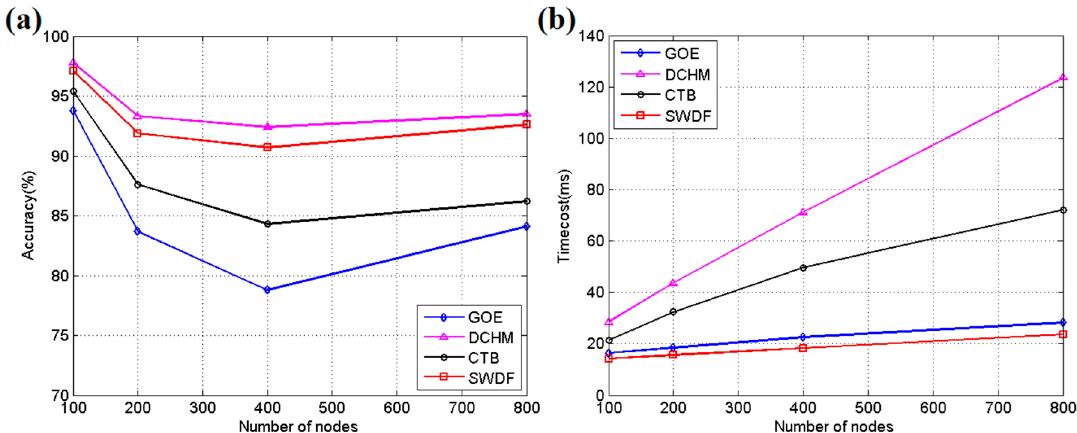
Figure 5. ( a ) The average accuracy for methods in the simulation; ( b ) The average time/cost for the methods in the simulation.